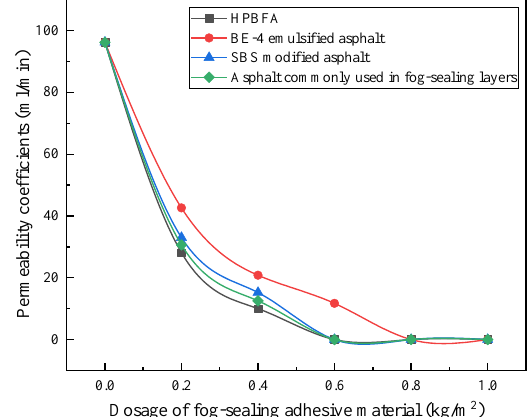
Figure 11. Experimental water-permeability coefficients.